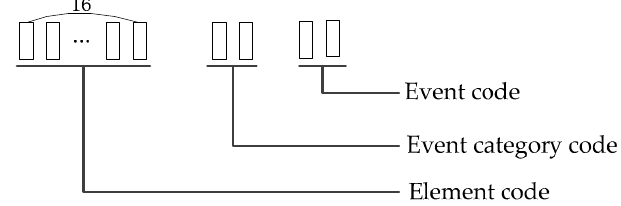
Figure 5. Code structure of grid events in the train operation department.